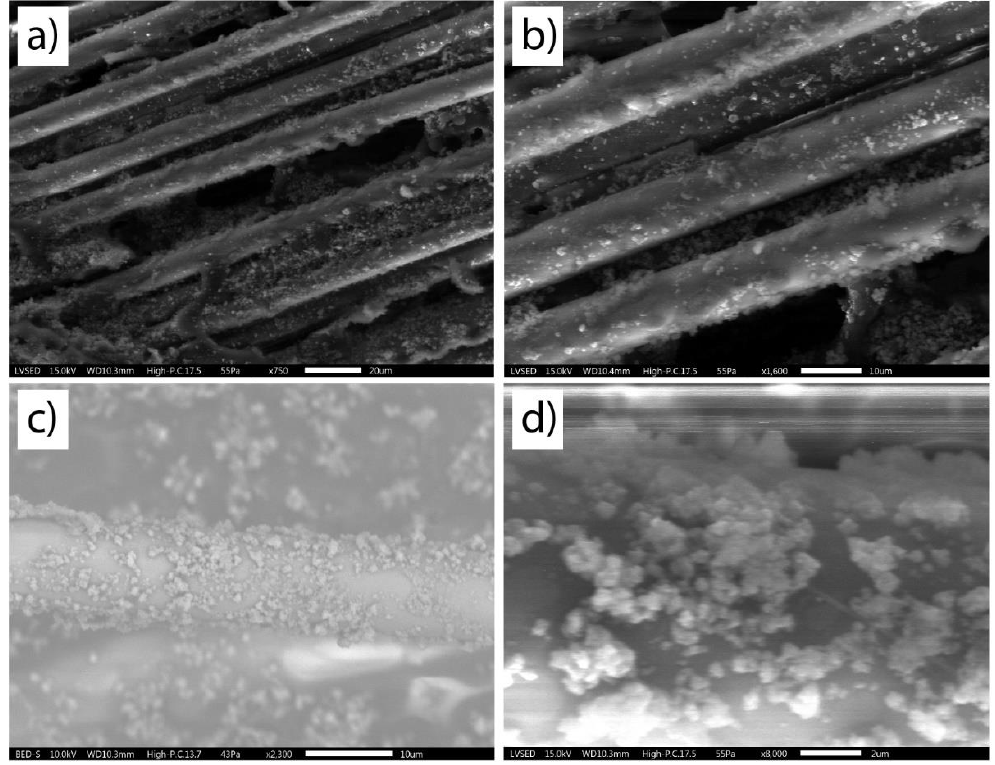
Figure 1. SEM images of the TiO 2 /fiberglass substrate ( a ) 750×; ( b ) 1600×; ( c ) 2300×; ( d ) 8000×.